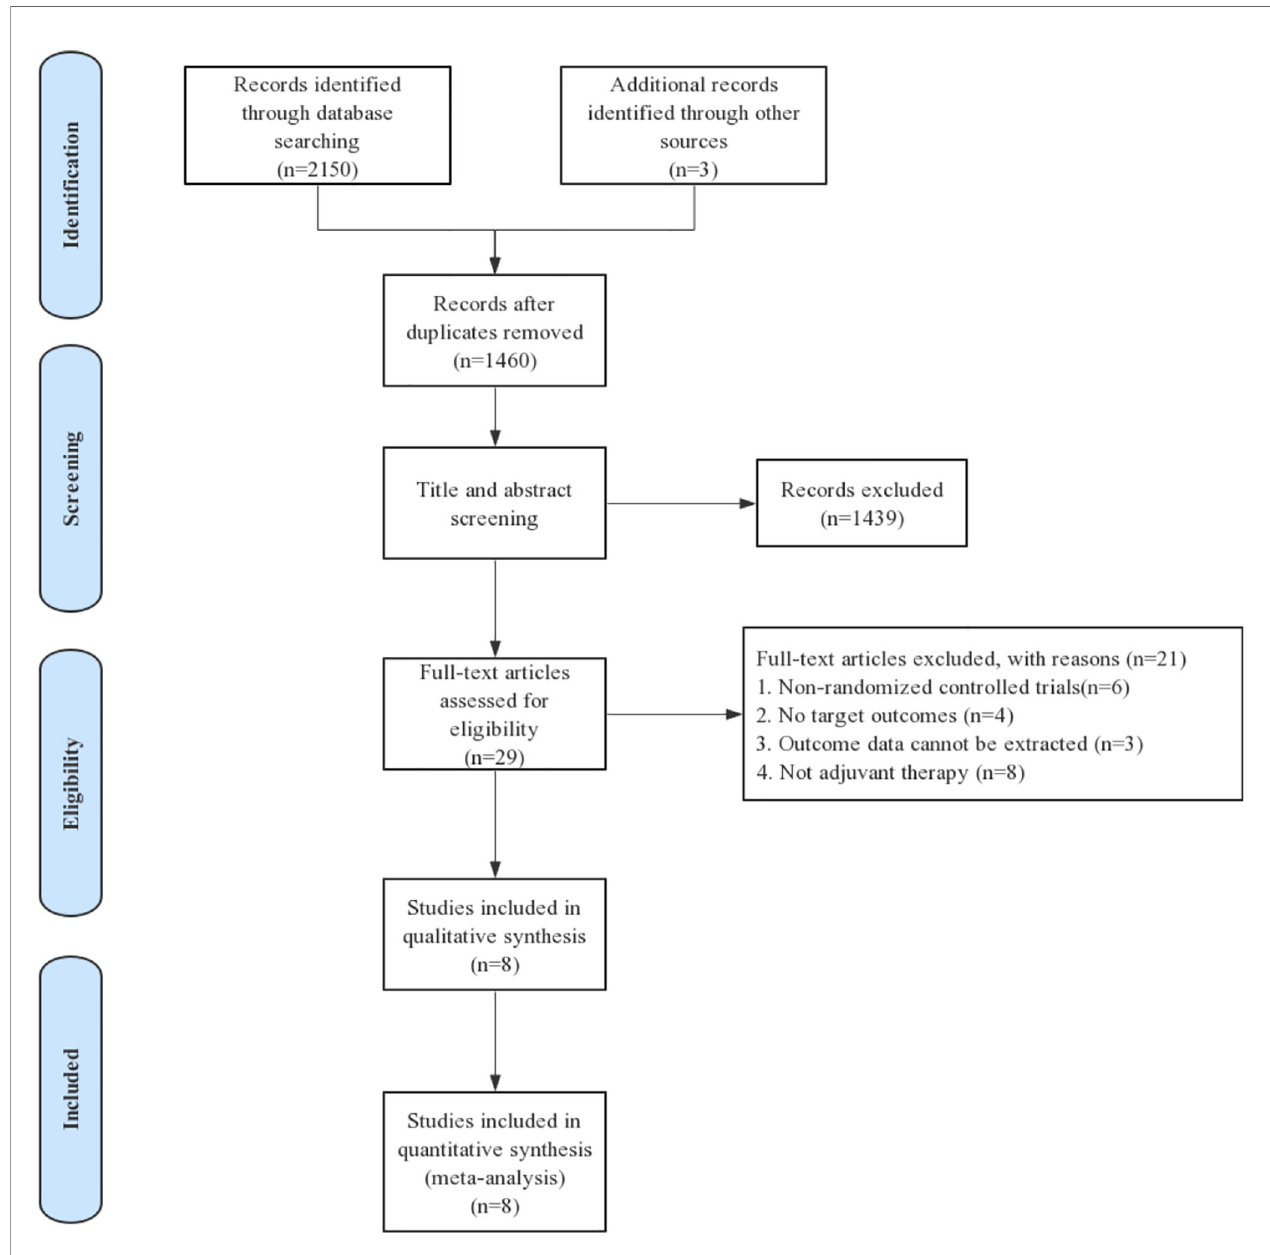
FIGURE 1 | PRISMA fl ow diagram the search strategy and